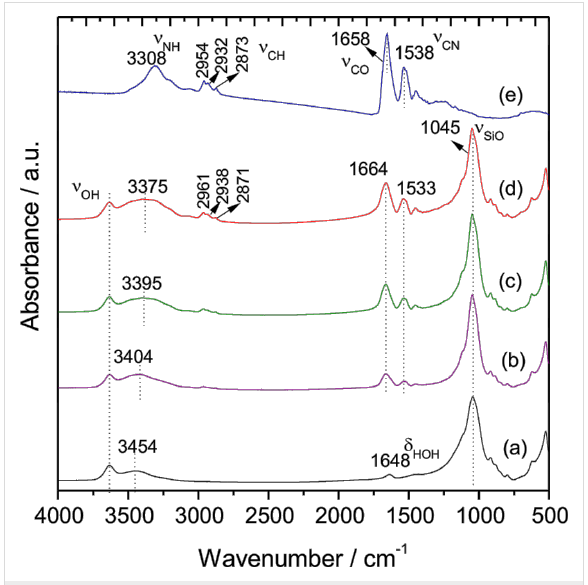
Figure 3: FTIR spectra in the 4000–500 cm − 1 region of (a) starting MMT, (b) Z-MMT_S2-9, (c) Z-MMT_S2-26 and (d) Z-MMT_S2-46 biohybrid materials, and (e) pristine